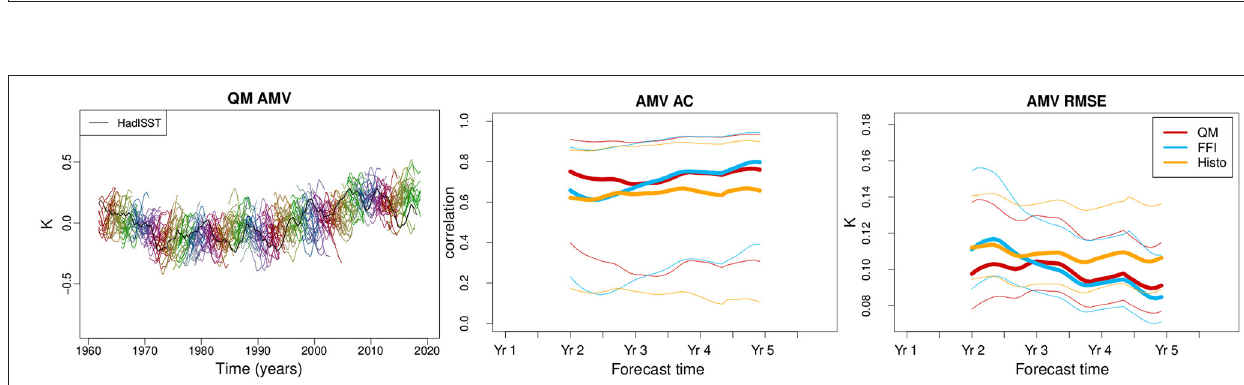
Frontiers in Climate |